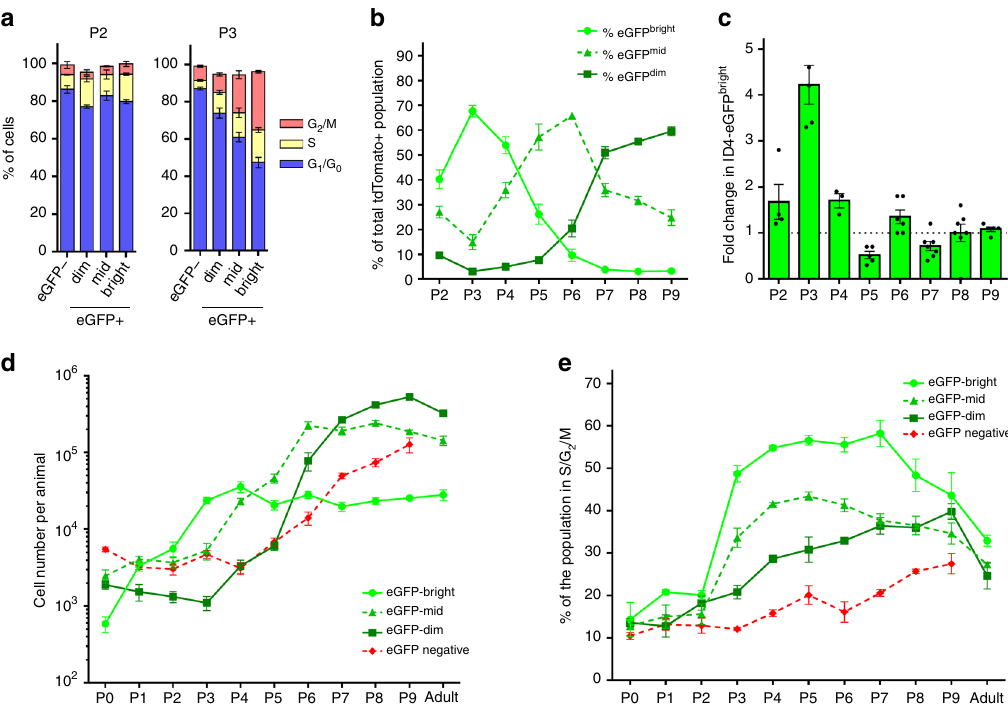
Fig. 2 Postnatal germ cell mitotic reactivation initiates SSC pool establishment. a Cell cycle analysis of germ cell subtypes at P2 and P3. b Percent germline distribution of ID4-eGFP + subsets. c Fold-change in number of ID4-eGFP Bright germ cells from the previous developmental day. d and e Cell number per animal ( d ) and cell cycle status ( e ) during development. Data in a – e are presented as means with error bars representing SEM for n = 3 – 7 biologically independent animals at each age point ( n = 3 for all cell cycle data; otherwise n = 4 for P1, P2, P4, and adult; n = 5 for P0, P3, P5, and P9; n = 6 for P6 and P8; n = 7 for P7). Source data are provided as a Source Data fi